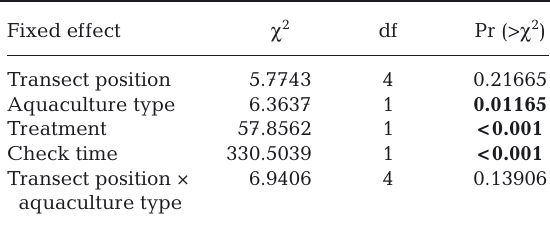
Table 3. Analysis of deviance results following a generalized linear mixed model fit for the predation tethering unit data (N = 3). Bold indicates significance (p <